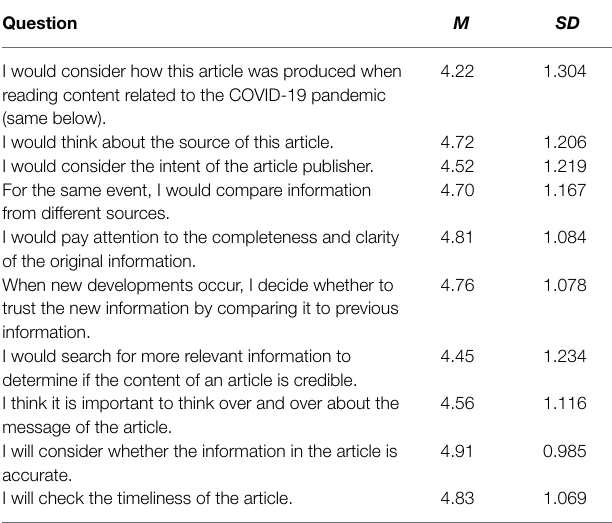
TABLE 2 | Media literacy of respondents.